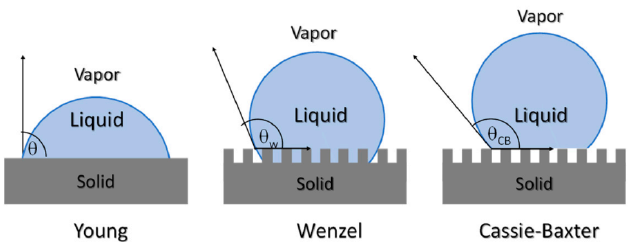
Figure 17. Scheme illustrating the different models used to interpret wettability behavior Young, Wenzel and